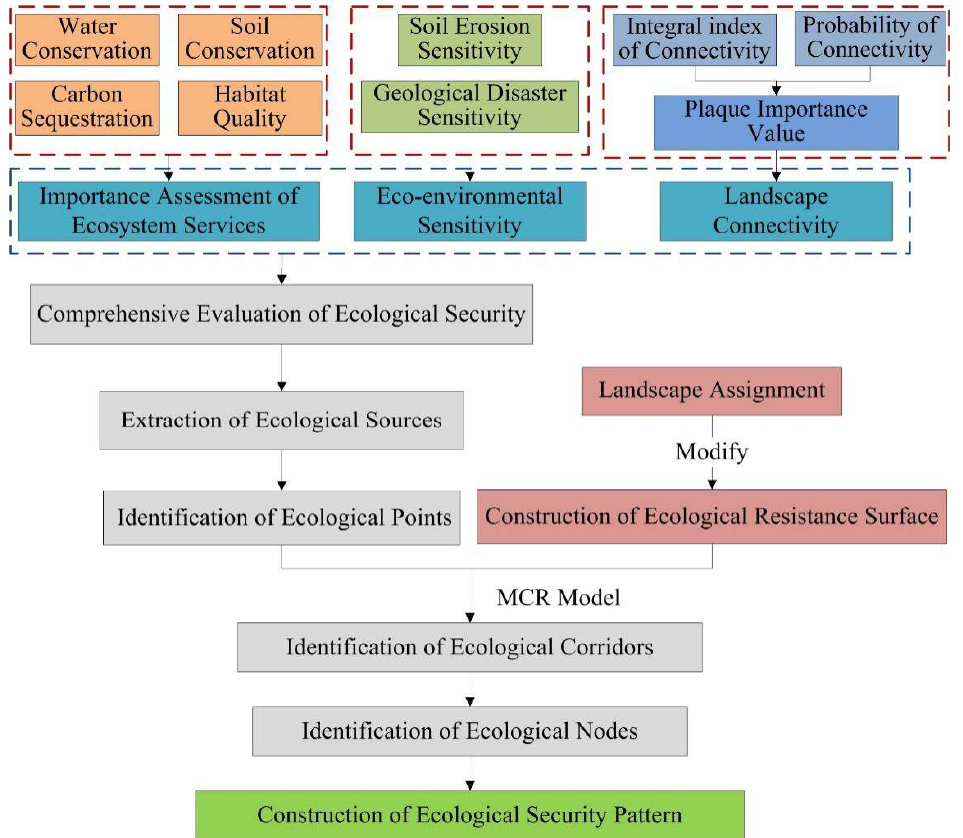
Figure 2. Technical route of constructing ecological security pattern